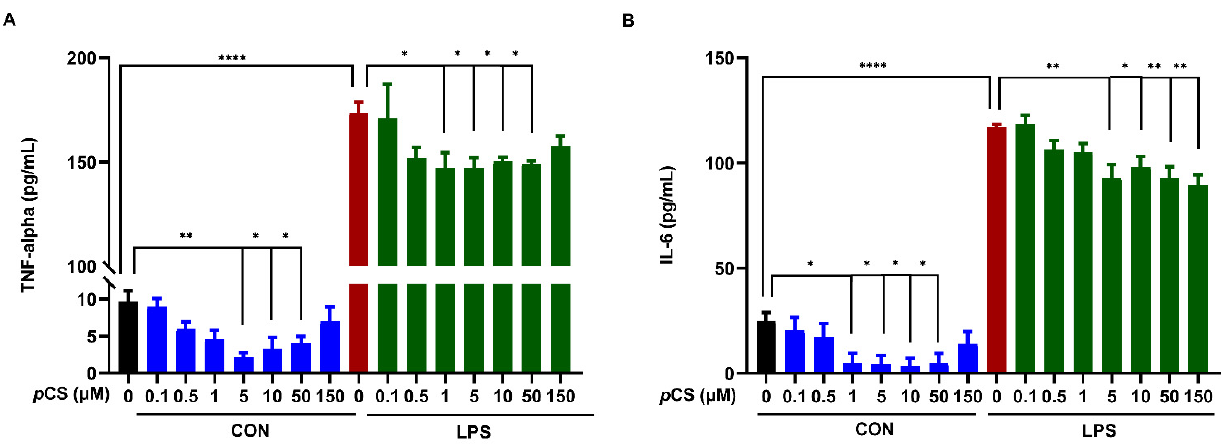
Figure 4. The effect of p CS on TNF- α and IL-6 releases by BV2 microglia. The BV2 microglial cells (5.000 per well) were incubated with p CS for 24 h with or without LPS (1000 ng/mL). ( A ) The concentration of TNF- α in culture medium: n = 3 from 3 independent experiments. ( B ) The concentration of IL-6 in culture medium: n = 4 from 4 independent experiments. Black: constitutive cytokine release; red: LPS-induced cytokine release; blue: effect of p CS on constitutive cytokine release; green: effect of p CS on LPS-induced cytokine release. Results are expressed as mean ± SEM. * p < 0.05, ** p < 0.01 , **** p < 0.0001.